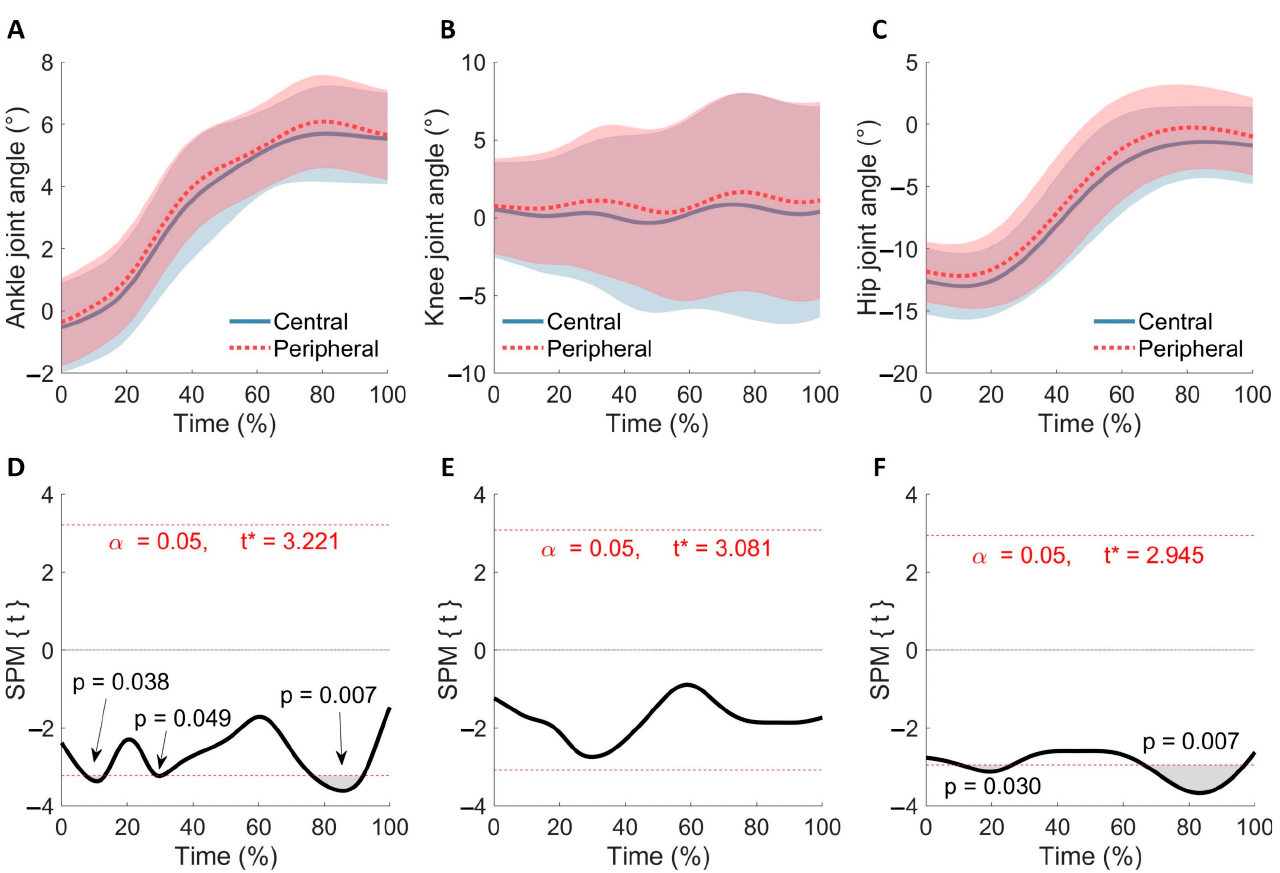
Figure 2. Frontal plane joint angle. Descriptive statistics for each condition (mean ± 1 standard deviation error cloud) for the ankle ( A ), knee ( B) , and hip ( C ) joint angles. Time was determined from initial contact (0%) to peak knee flexion (100%). The black line is the t-value of each time point for the ankle ( D ), knee ( E ), and hip ( F ) joint angles. The dotted redline is the threshold of significance. The gray areas are the time periods in which significant differences occurred. Statistical differences were detected in the frontal plane ankle ( D ) and hip ( F ) joint angle between the landing conditions. No significant difference was observed in the frontal plane knee joint angle ( E ).